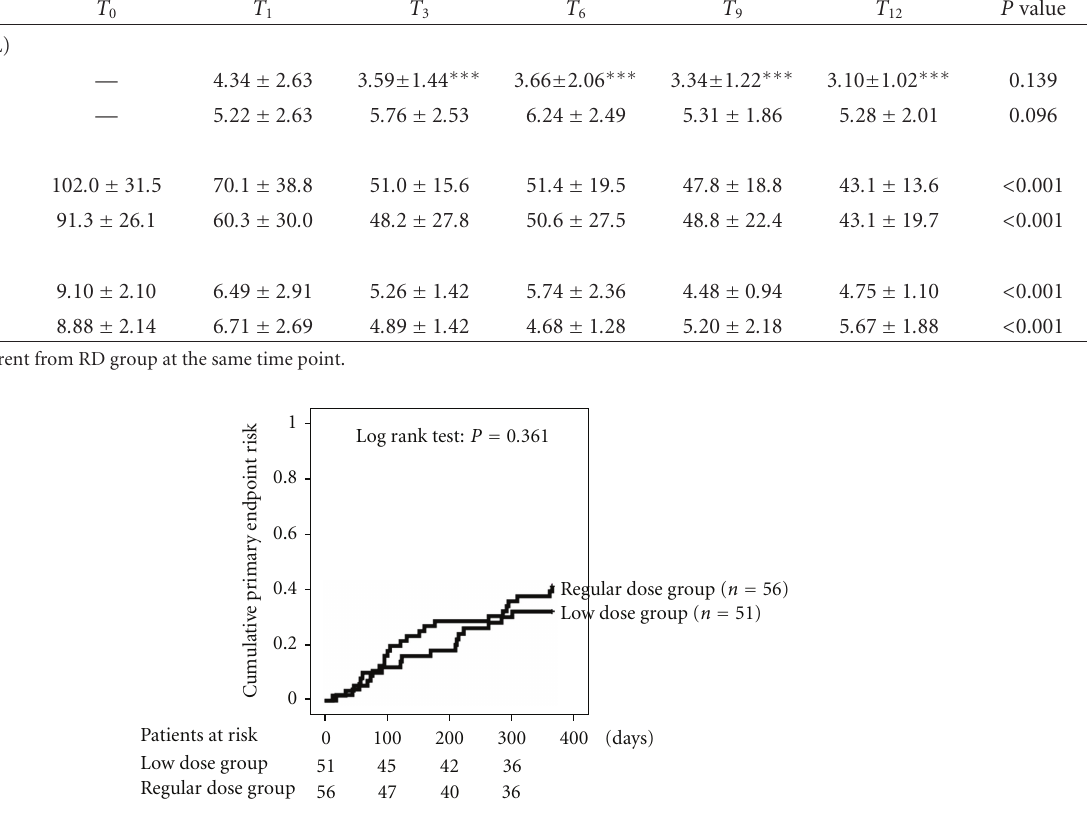
Figure 2: Cumulative risk of the primary endpoint. The primary endpoint was a composite of death, graft loss, everolimus discontinuation and